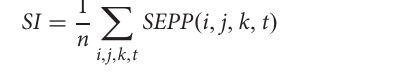
TABLE 2 | Mix model ANOVA results of the sum of number of eggs per pair of codling moth and covariates (year, apple cultivar, and season [early and late]).